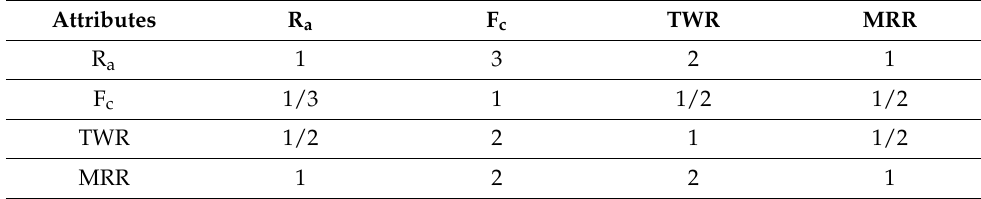
Table 4. Comparison matrix.